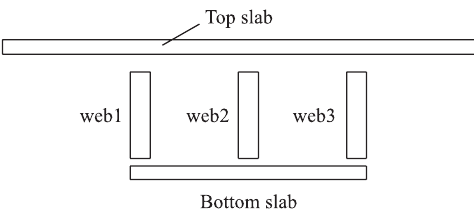
divideda b Fig. 5. Space-frame lattice model of steel-concrete composite cable-stayed bridge with twin main girder: a – space-frame lattice model of the whole bridge; b – a segment; c – section